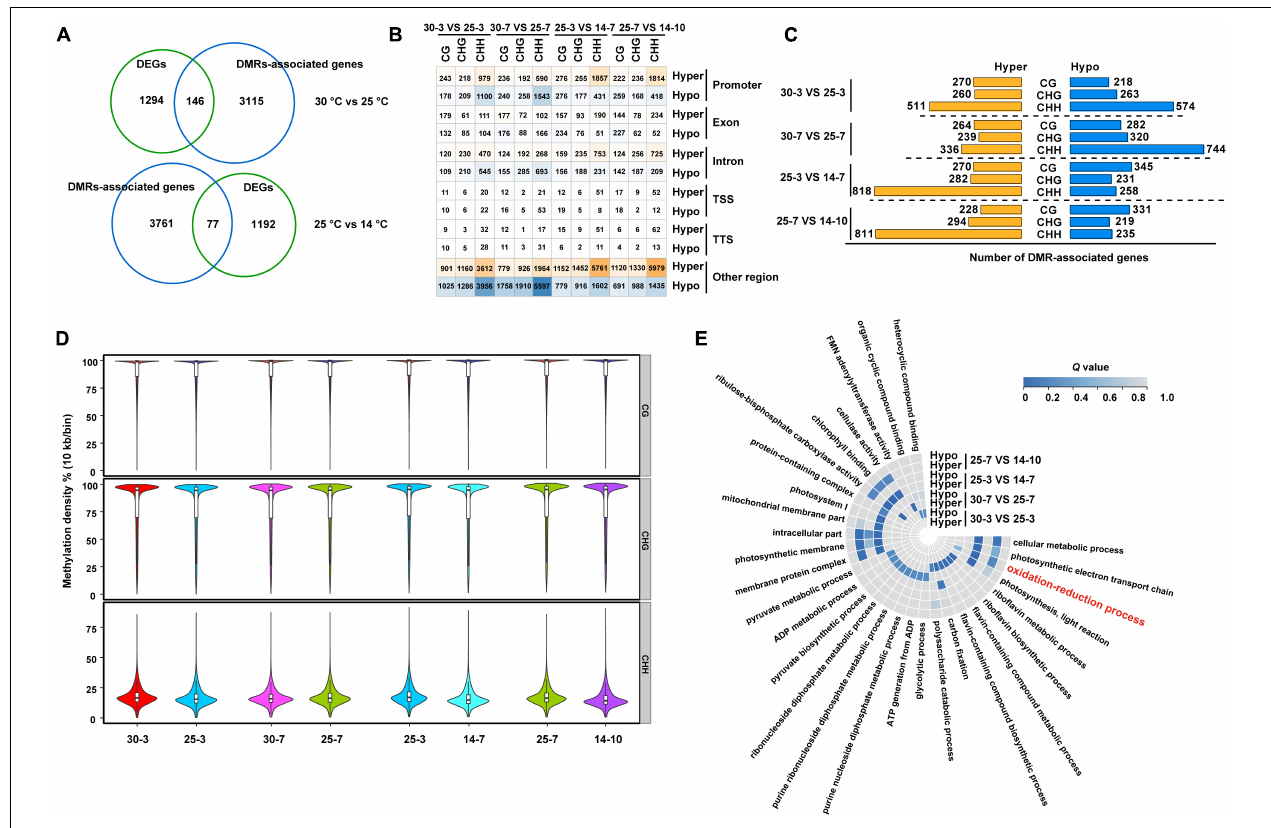
FIGURE 7 | Diverse regulatory roles of DNA methylation on gene expression during M. micrantha seeds development. (A) Numbers of DMR-associated genes (a blue circle) and differentially expressed genes (a green circle) between successive stages of seed development are shown in the Venn diagrams. (B) A number of DEGs that are differentially methylated (hyper/hypo) in three sequence contexts (CG, CHG, and CHH) and genic regions between successive stages of seed development are given. Intensity of orange and blue indicates number of DMR-associated upregulated and downregulated genes, respectively. (C) Numbers of DMRs-associated genes identified from four comparisons selected stages of seed development (3 rd day at 30 and 25 ◦ C; 7 th day at 30 and 25 ◦ C; 3 rd day at 25 ◦ C and 7 th day at 14 ◦ C; 7 th day at 25 ◦ C and 10 th day at 14 ◦ C) are given in hyper/hypo-methylated with different sequence contexts via bar graphs. (D) A methylation level at individual mC in different sequence contexts at both stages of seed development at three temperatures is shown via boxplot. (E) Gene ontology (GO) analysis of DMR-associated genes (hyper/hypo methylated) at four comparisons is shown via a heatmap. The scale represents the Q -value of enriched GO